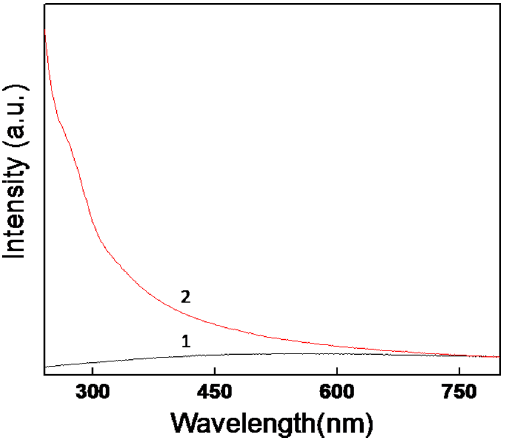
Figure 1. UV-visible spectroscopy measurements of Fly-ash powder curve (1) and the bioleached silica nanoparticles after a reaction of 24 h between the fungus Fusariumoxysporum and Fly-ash powder curve (2).